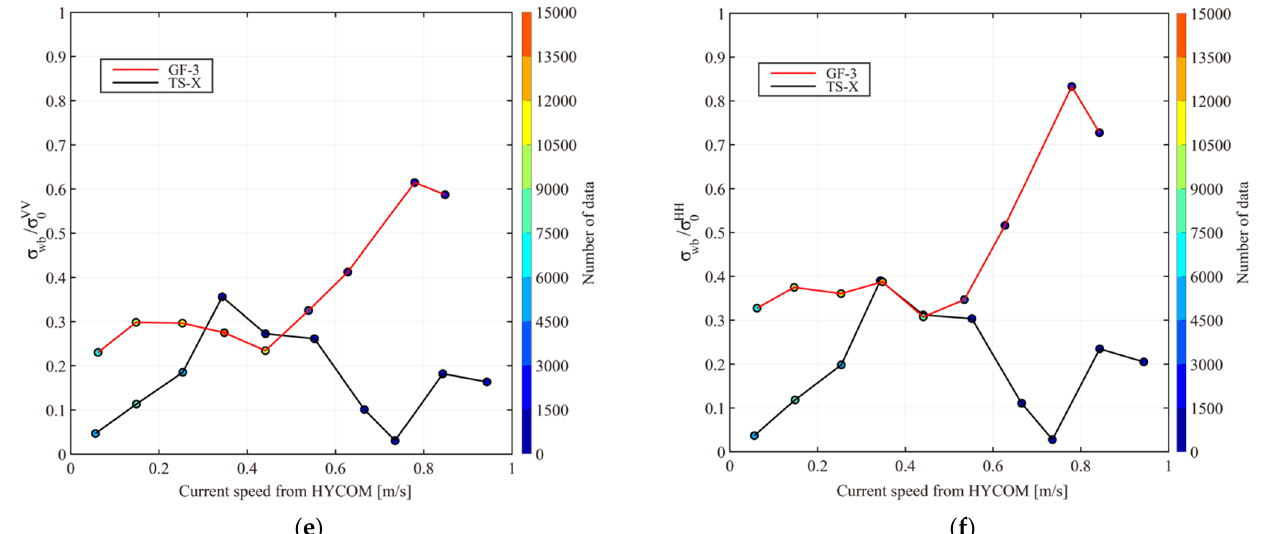
VV and σ HH ) and the ( a , b ) SAR-derived wind / σ wb and σ wb / σ HH ) and the ( a , b ) SAR-derived wind 0 0 0 0